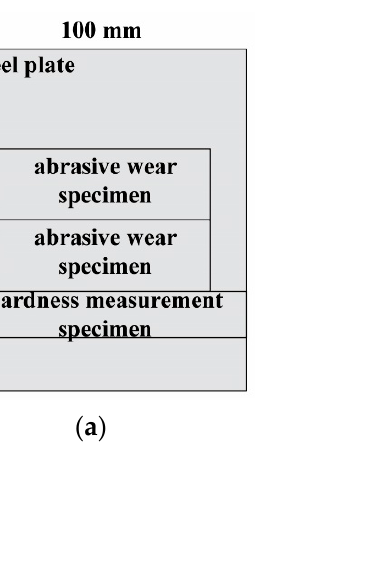
Figure Figure 2. The schematic view of cutting of specimens for investigations:( a ) top view;( b ) cross-section—specimen for abrasive wear resistance test; ( c ) cross-section—specimen for hardness measurements.